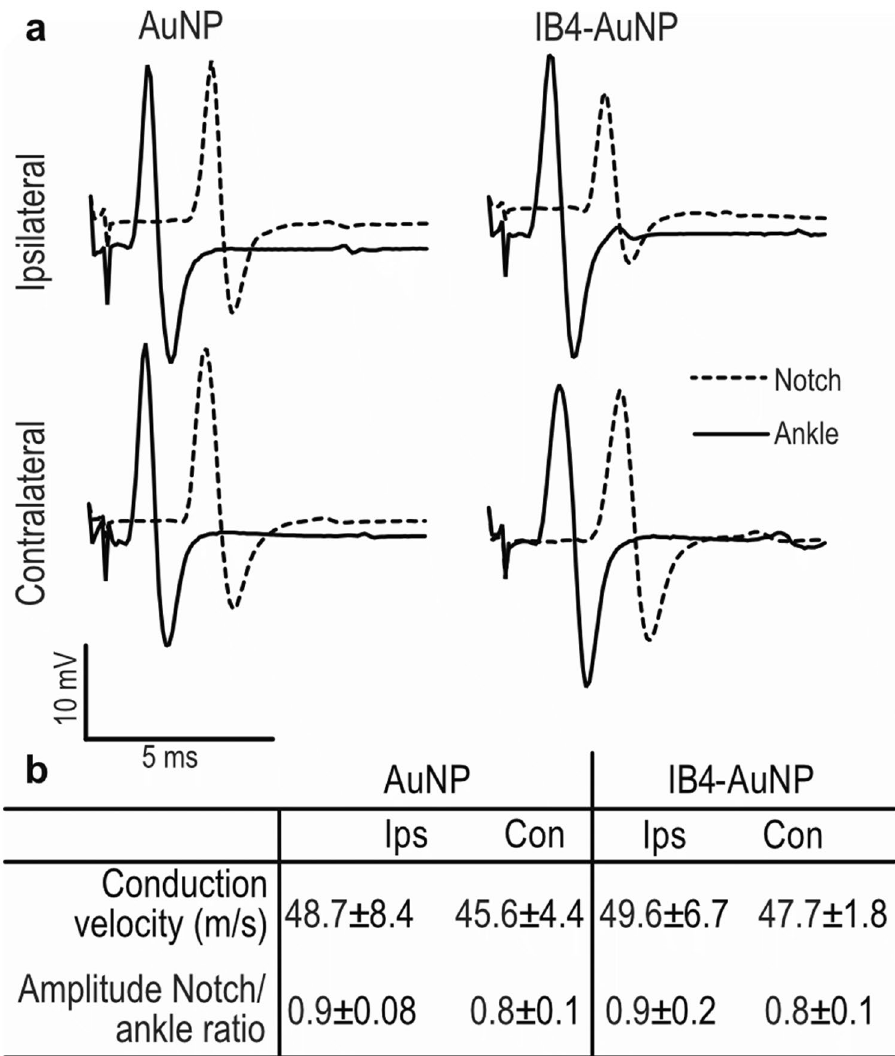
Figure 7. Peripheral sciatic nerve function of rats exposed to topical AuNP. Representative electrophysiological tracings obtained from the plantaris muscle by stimulating the sciatic nerve at the ankle and sciatic notch from AuNP (a) and IB4-AuNP treated rats. Conduction velocity and signal amplitudes are shown in (b) . Data shown are mean ± S.D., n = 4. (ips = ipsilateral; con =